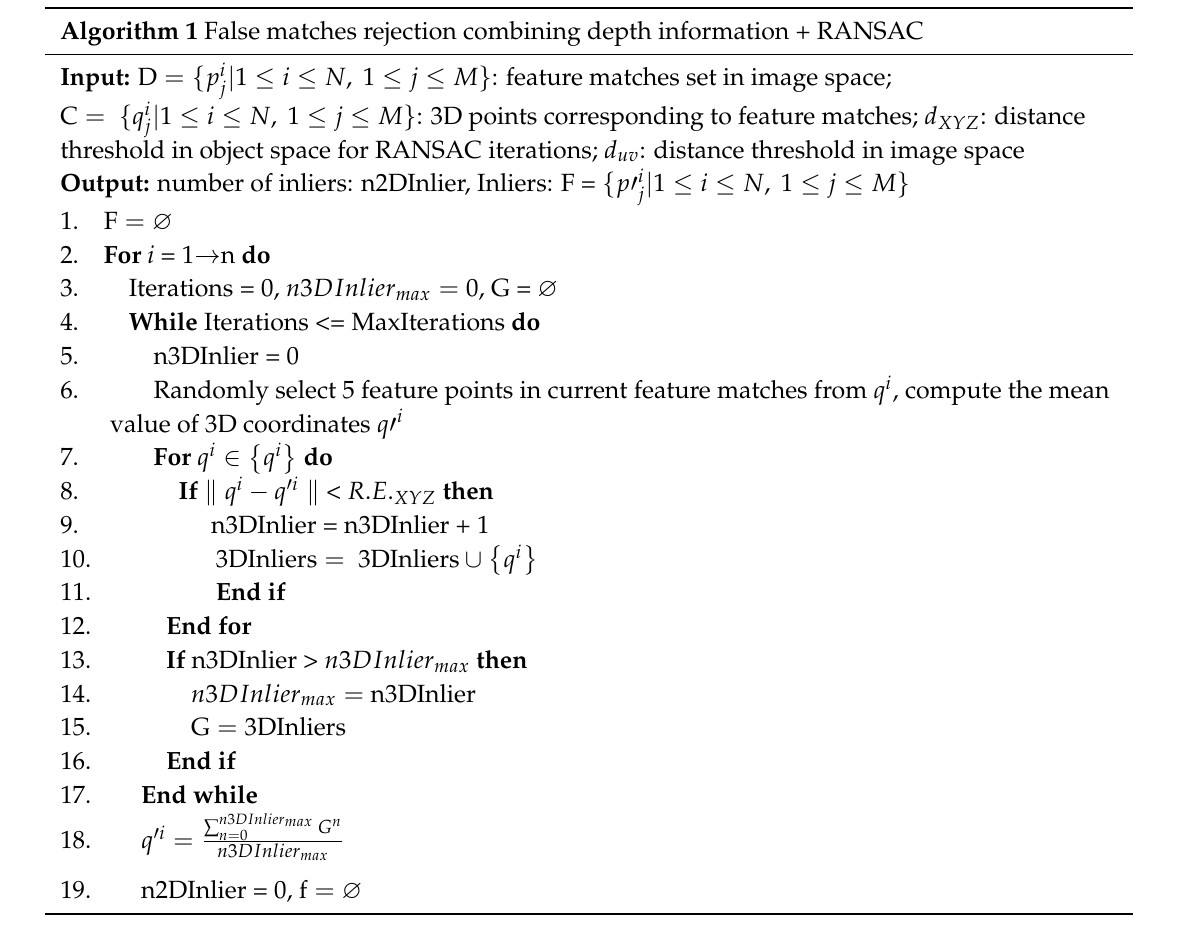
Algorithm 1 False matches rejection combining depth information +